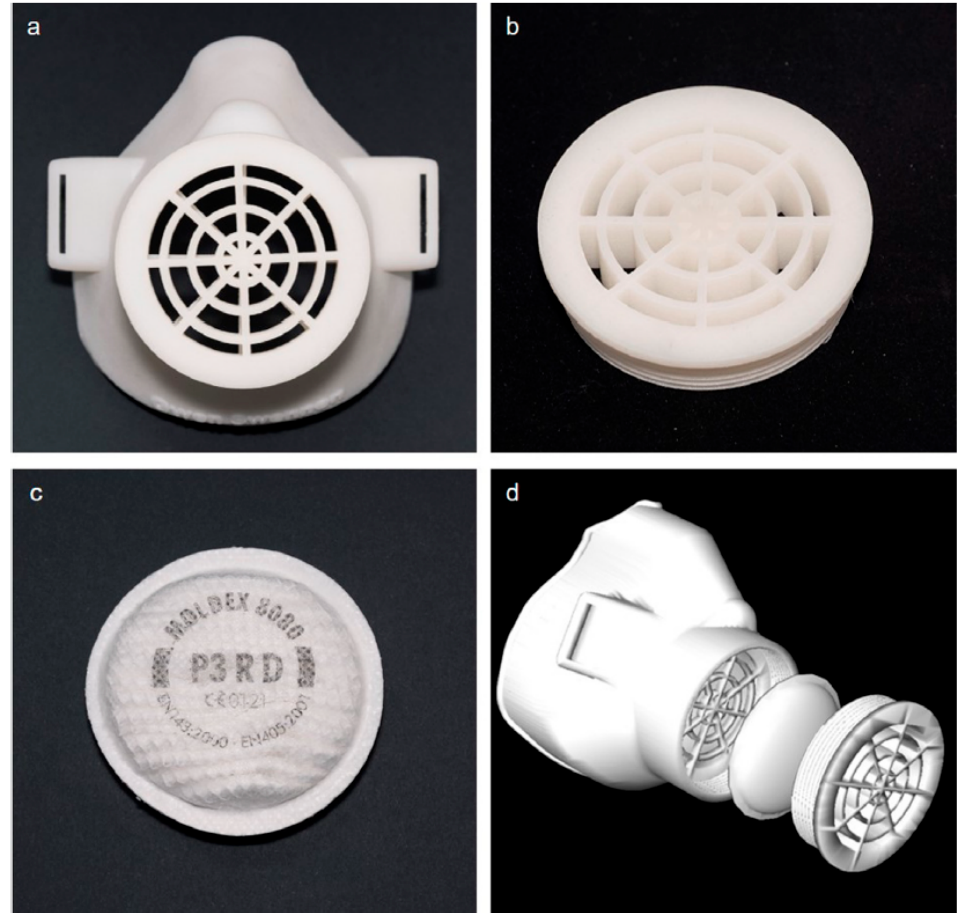
Figure 9. Typical representation of the 3D-printed face mask: ( a ) reusable 3D printed face mask, ( b ) filter membrane support, ( c ) polypropylene (PP) nonwoven meltblown particle filter, ( d ) 3D image of the prototype [53].